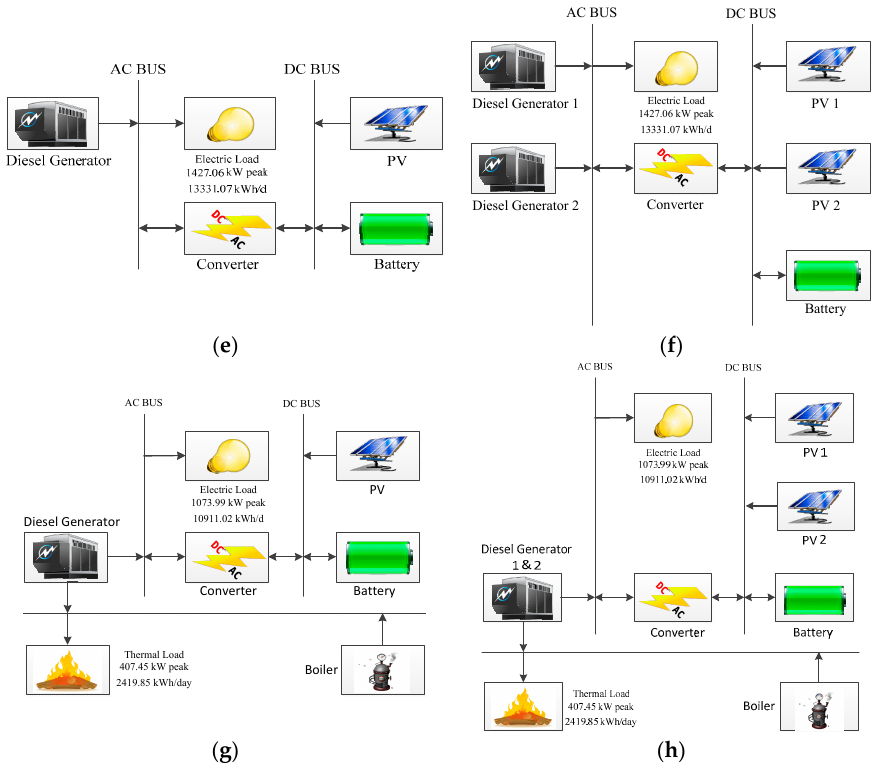
Figure 7. ( a ) Isolated single generator (1Gen) and single PV (1PV) without WHR system ( b ) Isolated double generator (2Gen) and double PV (2PV) without WHR system ( c ) Isolated single generator (1Gen) and single PV (1PV) with WHR system ( d ) Isolated double generator (2Gen) and double PV (2PV) with WHR system ( e ) Isolated single generator (1Gen), single PV (1PV) and battery without WHR system ( f ) Isolated double generator (2Gen), double PV (2PV) and battery without WHR system ( g ) Isolated single generator (1Gen), single PV (1PV) and battery with WHR system ( h ) Isolated double generator (2Gen), double PV (2PV) and battery with WHR system.